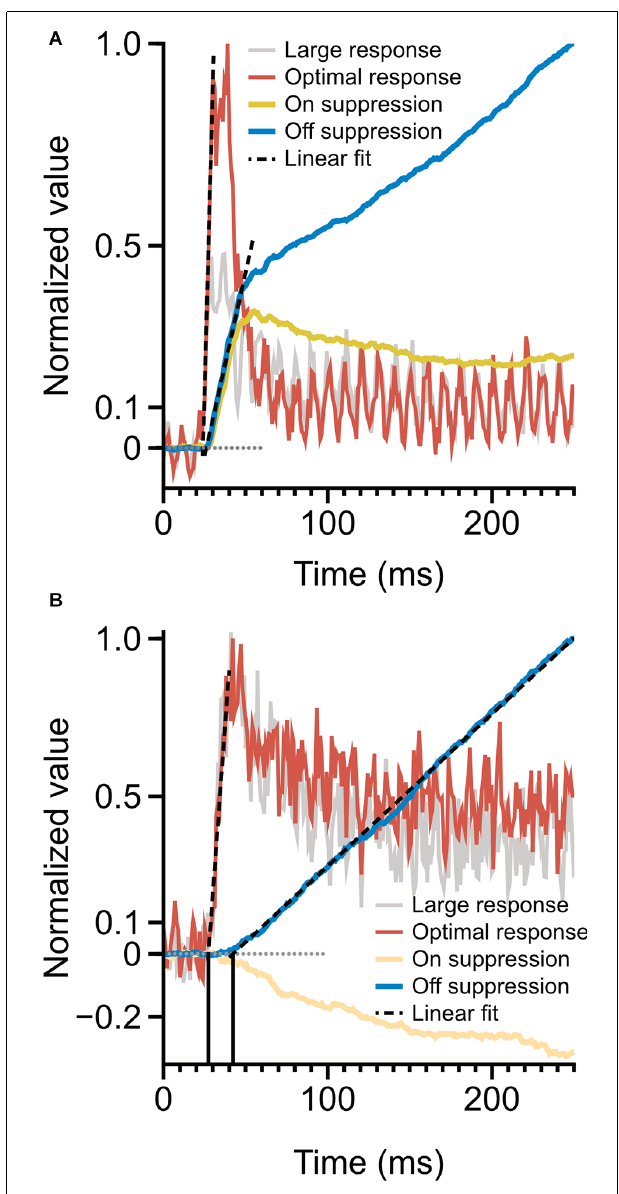
FIGURE 6 | Time-course of spiking response and monocular surround suppression. (A) Magnocellular cells, monocular surround suppression in the On and Off channels overlaid on mean magnocellular-cell spiking response. Late-stage suppression becomes active as the rate transient drops to plateau. The onset of suppression is simultaneous with spiking response onset. (B) Parvocellular cells, monocular surround suppression in the On and Off cells overlaid on mean parvocellular-cell spiking response. Dotted lines depict linear fits to response onset and to the rising portion of cumulative suppression. The onset of suppression is delayed by 15 ms (vertical lines) relative to spiking response. Latencies are computed as the x-intercept of linear